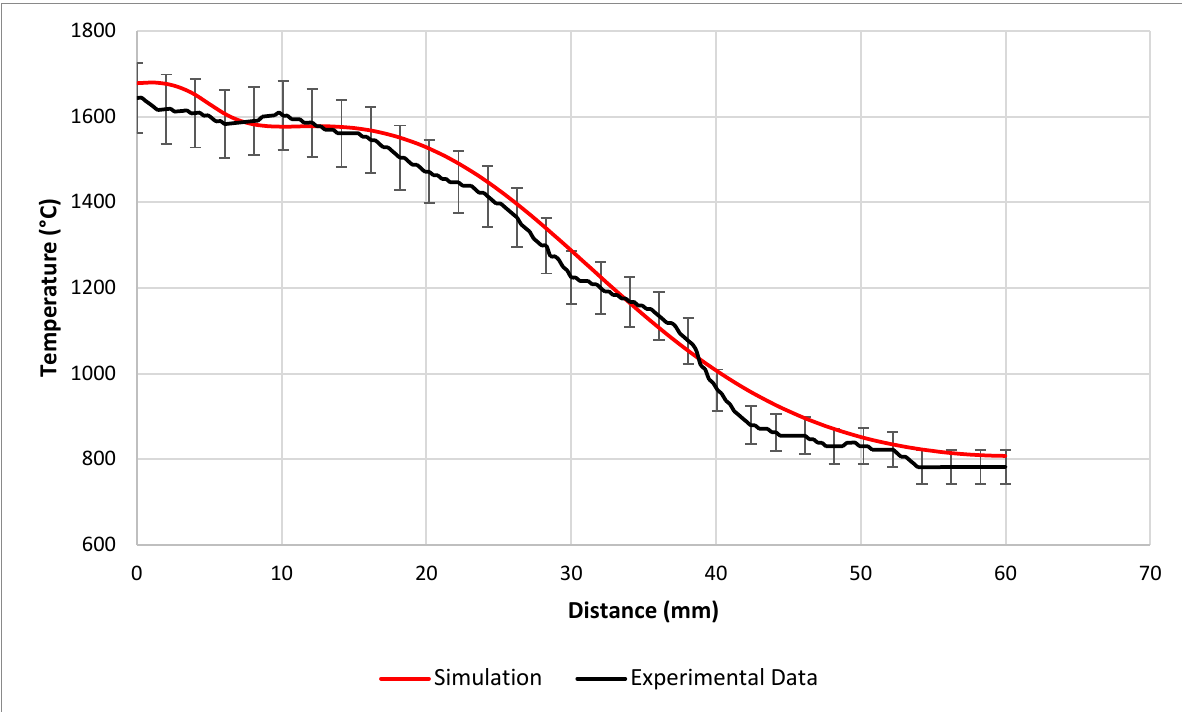
Figure 11. Comparison of the simulation’s thermal profile along the weld interface to the experi ‐ mental thermal profile.